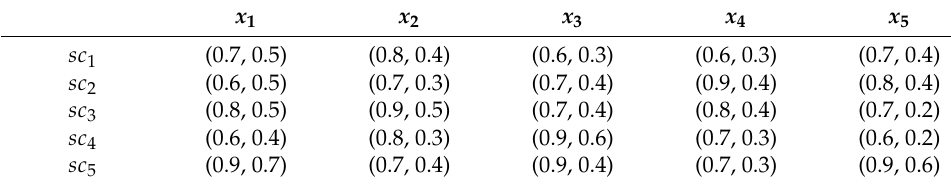
Table 4. Appraisal matrix A 2 by DM-2.